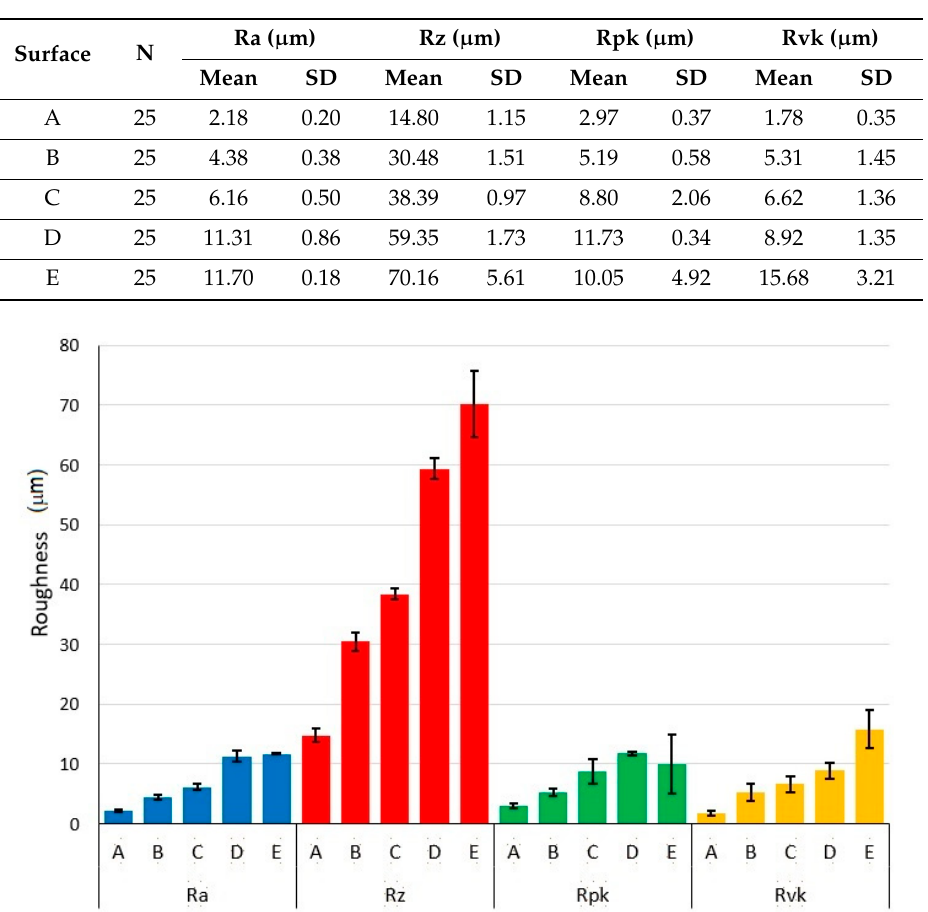
Figure 4. Roughness development depending on applied pulse energies.